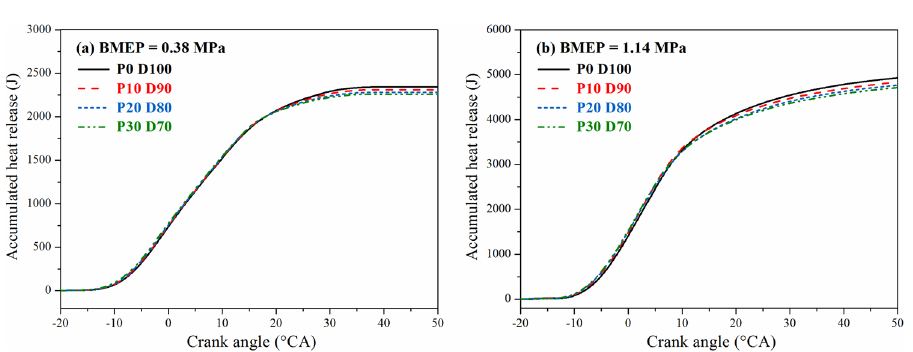
Figure 5. Effects of PODE n blending ratio on cumulative heat